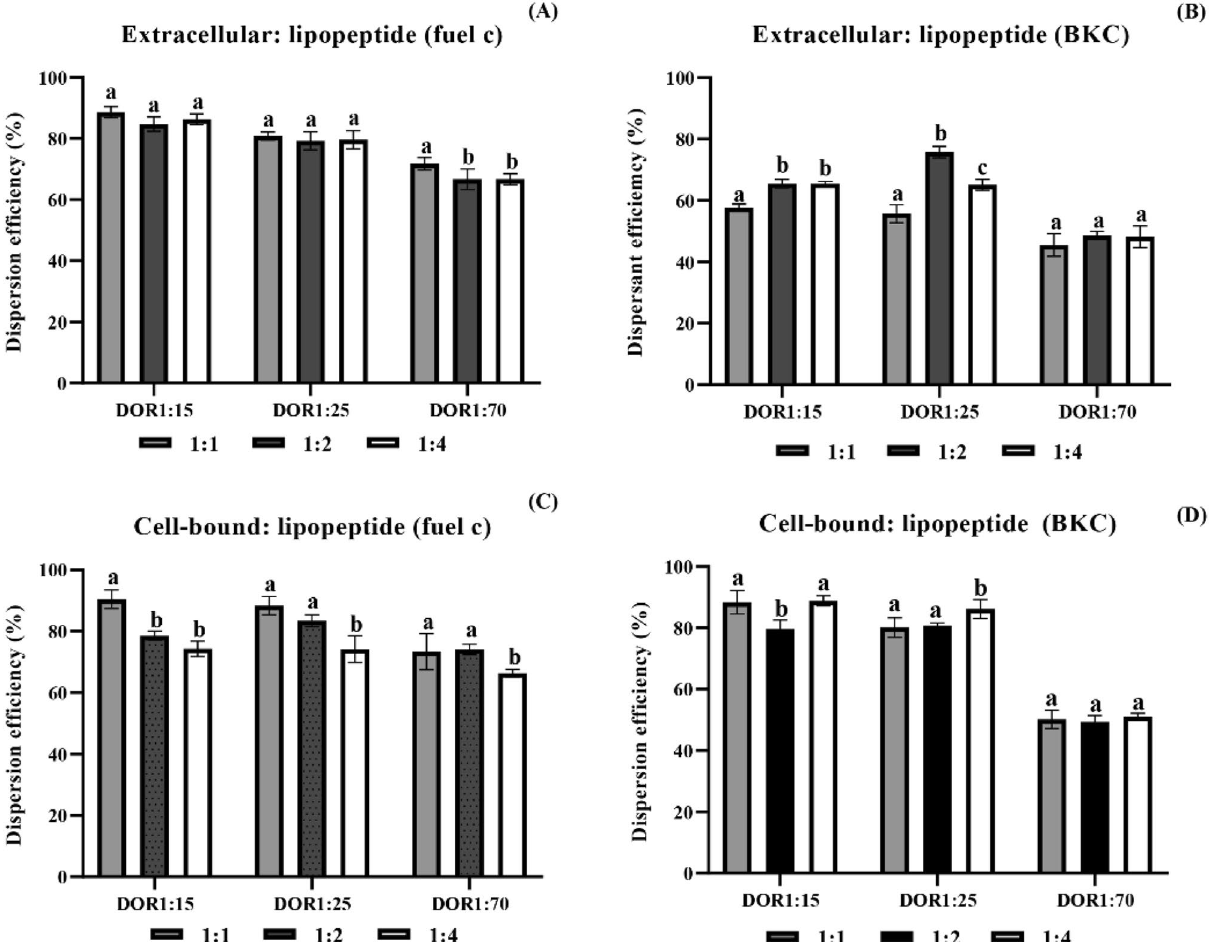
BKC crude oil ( B , D ). Error bars represent the mean ± standard deviation (n = 3). Two-way ANOVA: Tukey’s multiple comparison test was used for statistical analysis. Different letters represent statistically significant differences ( p <